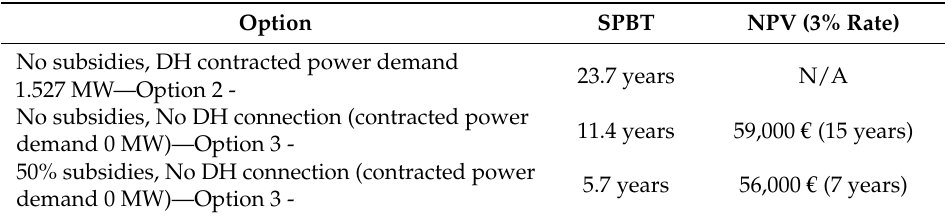
Table 5. Capital expenditures analysis results for the three heat reuse options